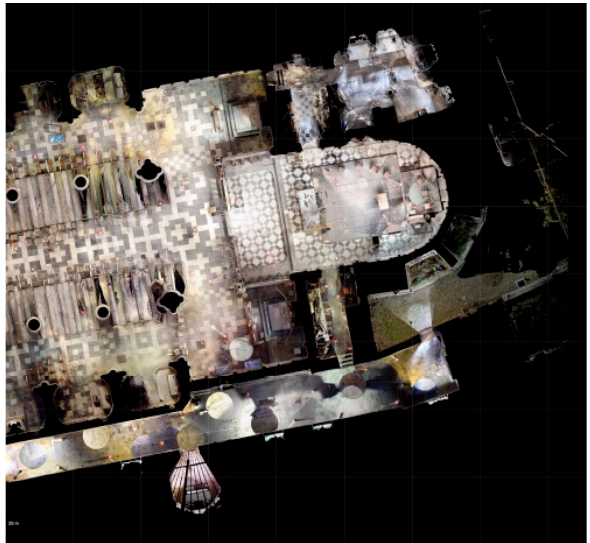
Figure 9 . A subset of the point cloud of the collegiate Sainte Croix